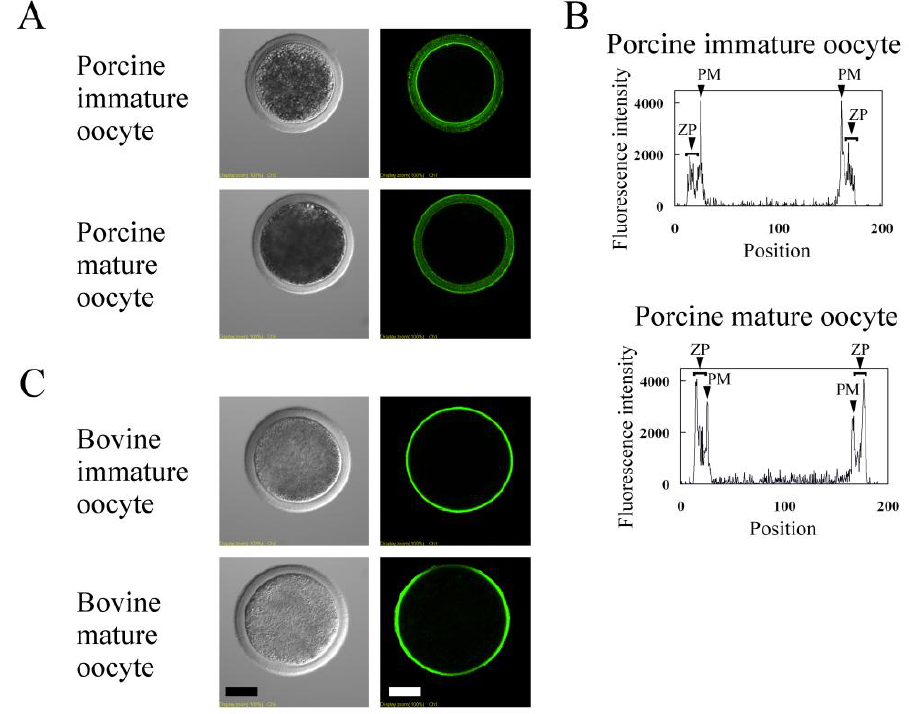
Figure 5. Localization of biotin-conjugated GNA-lectin in the porcine zona pellucida ( A and B ) and of RCA-lectin in the bovine zona pellucida ( C ). Left panels in A and C, phase-contrast; right panels in A and C, fluorescence. In the pig, the vertical sectional fluorescence intensities (arbitrary scale) are also shown ( B ). ZP, zona pellucida; PM, plasma membrane. Scale bar = 50